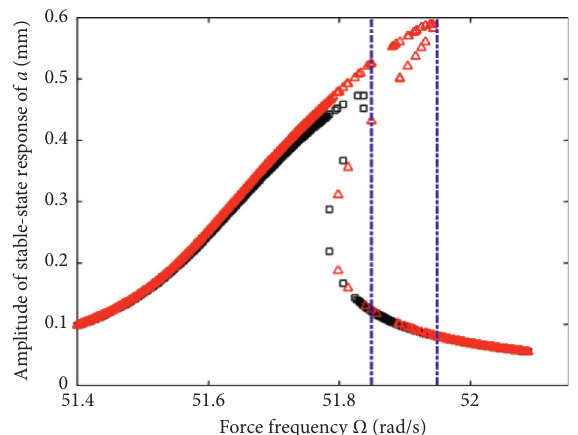
Figure 10: Amplitude frequency responses before and after damping changes.